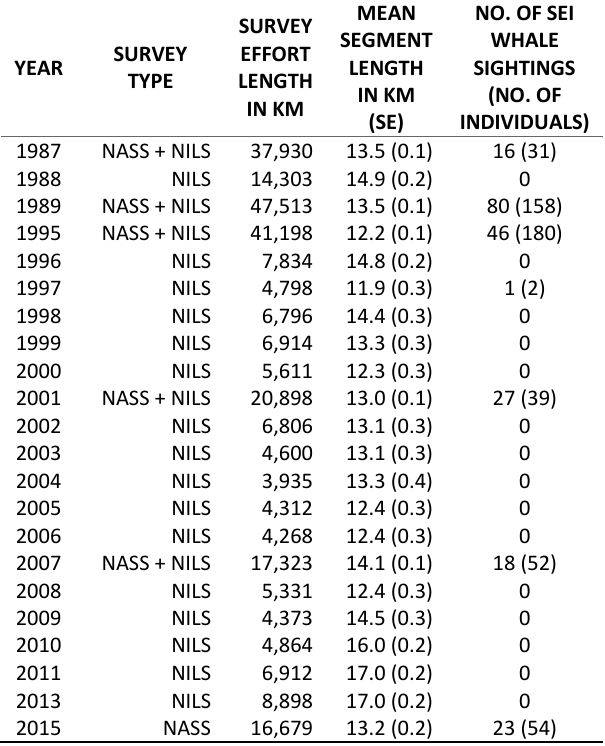
Table 1. Summary of NASS and NILS survey effort for each year. Details include the distance surveyed, mean segment length to nearest 0.1 km (SE = standard error), and number of sei whale sightings per